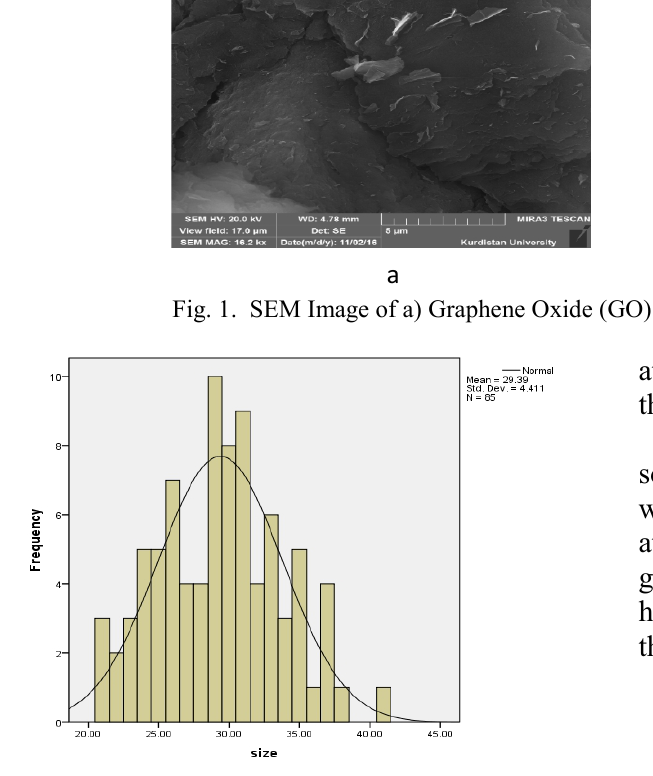
Fig. 2. Normal distribution of ZnO-Mn Nanocomposites on GO Surface